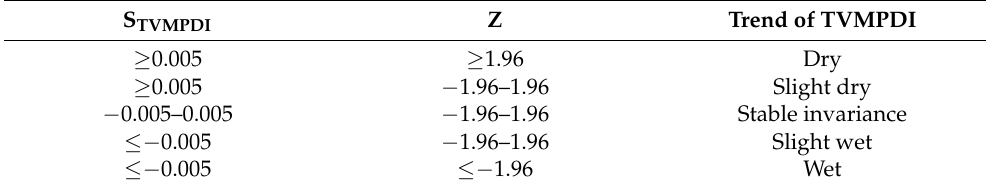
Table 4. Statistics of the TVMPDI